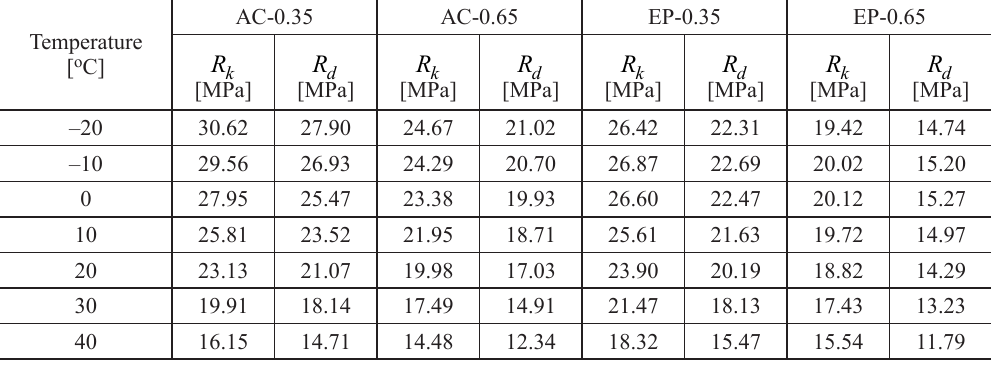
Table 3. Characteristic and design values , k